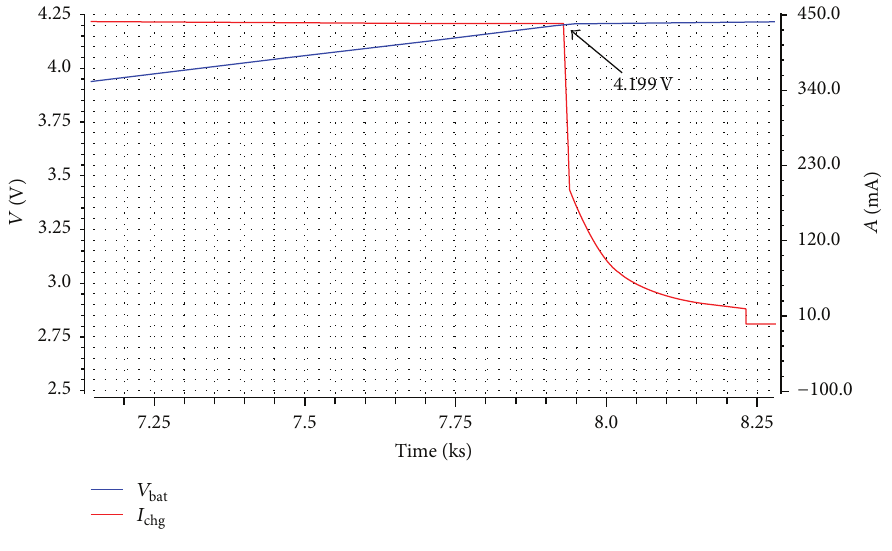
Figure 11: Transition from CC to CV mode.